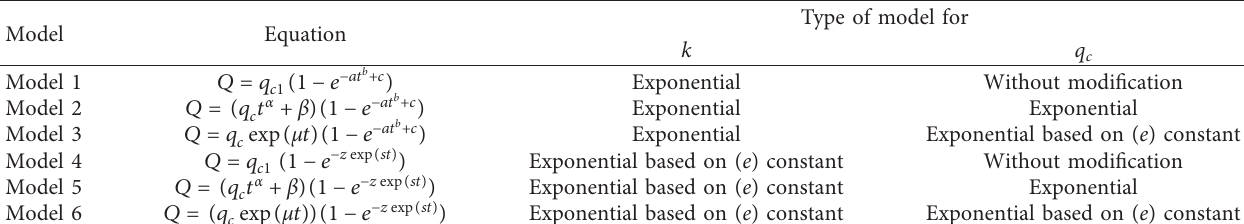
Table 2: Selected approximations for constants of kinetic models for numerical approach.